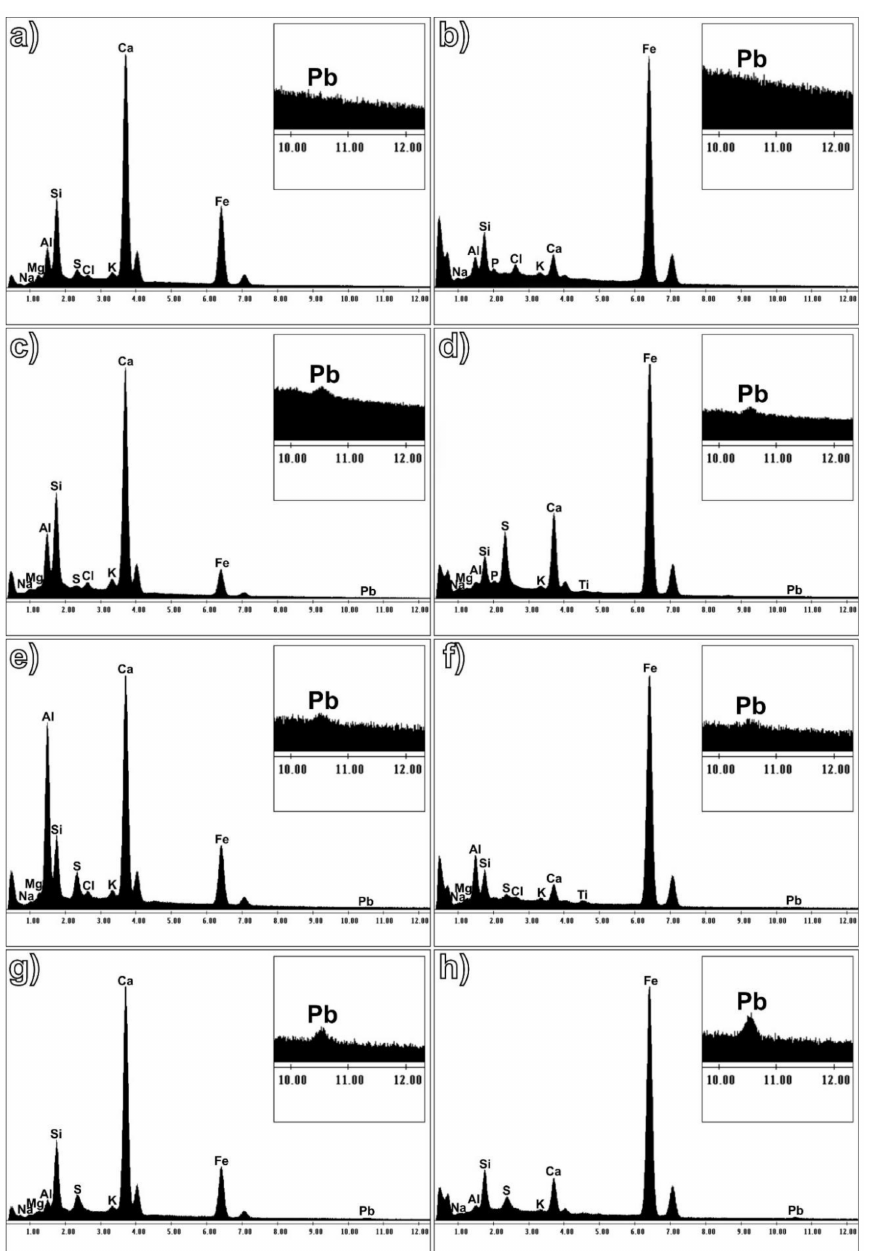
Figure 9. Representative EDS microanalyses of the Herculaneum samples, with the K α peaks of the recognized elements indicated, apart from Pb, which was identified through the L α line (magnification of the area of interest is reported in the upper box). ( a ) BCN_28, paint layer matrix; ( b ) BCN_28, pigment lump; ( c ) BCN_W1_03, paint layer matrix; ( d ) BCN_W1_03, pigment lump; ( e ) BCN_51, paint layer matrix; ( f ) BCN_51, pigment lump; ( g ) BCN_67, paint layer matrix; ( h ) BCN_67, pigment